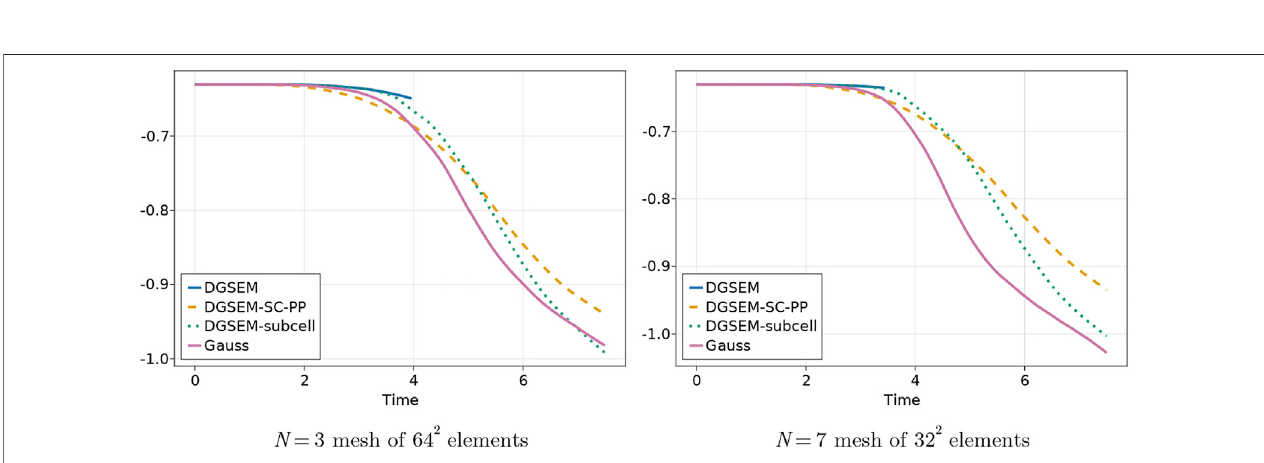
FIGURE 9 | Evolution of entropy over time for the Kelvin-Helmholtz